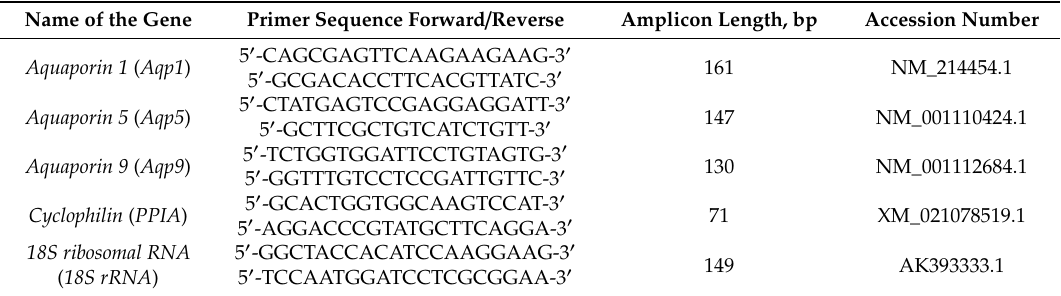
Table 2. Forward and reverse primers sequences, amplicons length and GeneBank accession numbers of genes used during Real-Time PCR